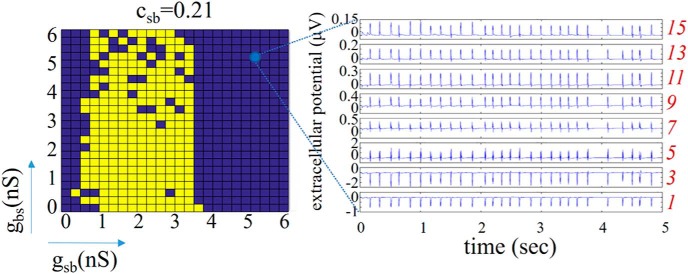
Predicted regime. For csb = 0.21, selected parameter sets (purple) include gsb values of 3.5–6 nS, and all gbs values. Rejected sets are in purple. On the right are LFP traces from 8 electrodes for a parameter set of gsb = 4.75, gbs = 4.50 nS.